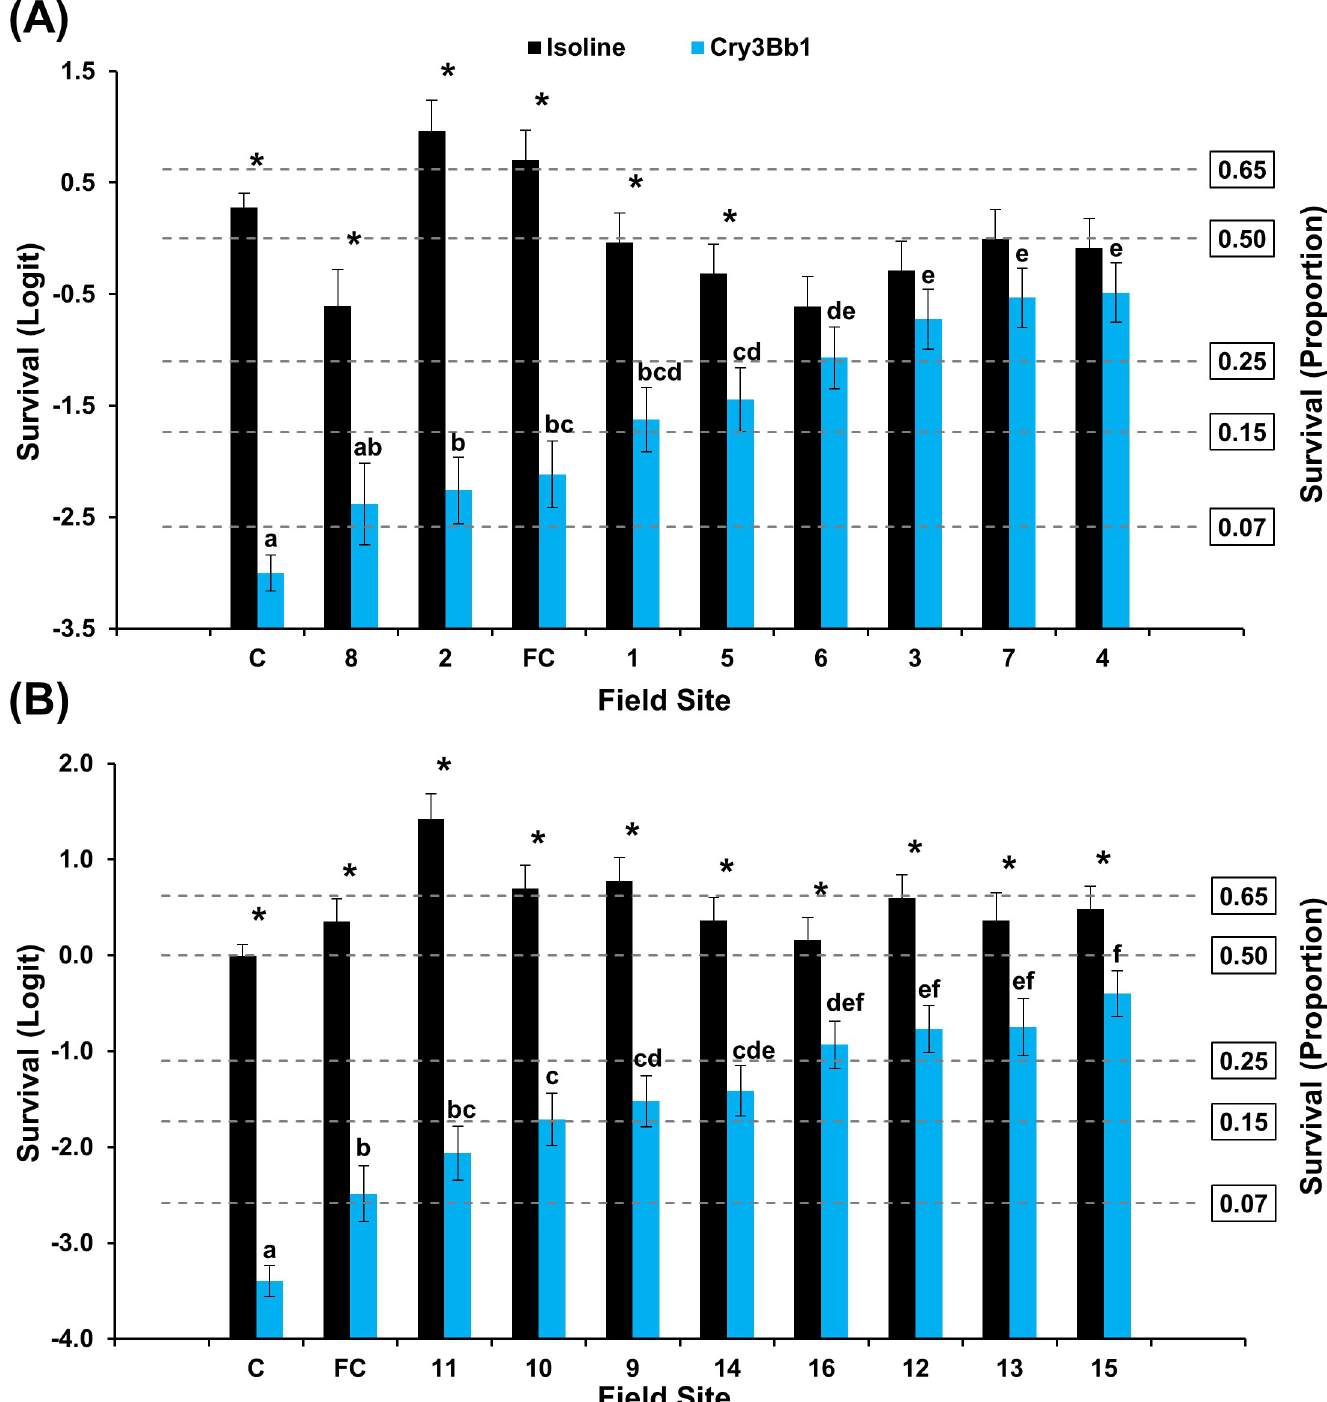
Fig 4. Mean WCR larval survival ( ± SE) of Buffalo County populations on Cry3Bb1 and its isoline. (A) 2016 bioassays. (B) 2017 bioassays. C = composite laboratory control; FC = field control. � indicates significantly higher survival on isoline compared to Cry3Bb1. Within years, Cry3Bb1 means with the same letter were not significantly different (generalized linear model, P > 0.05; LSMEANS